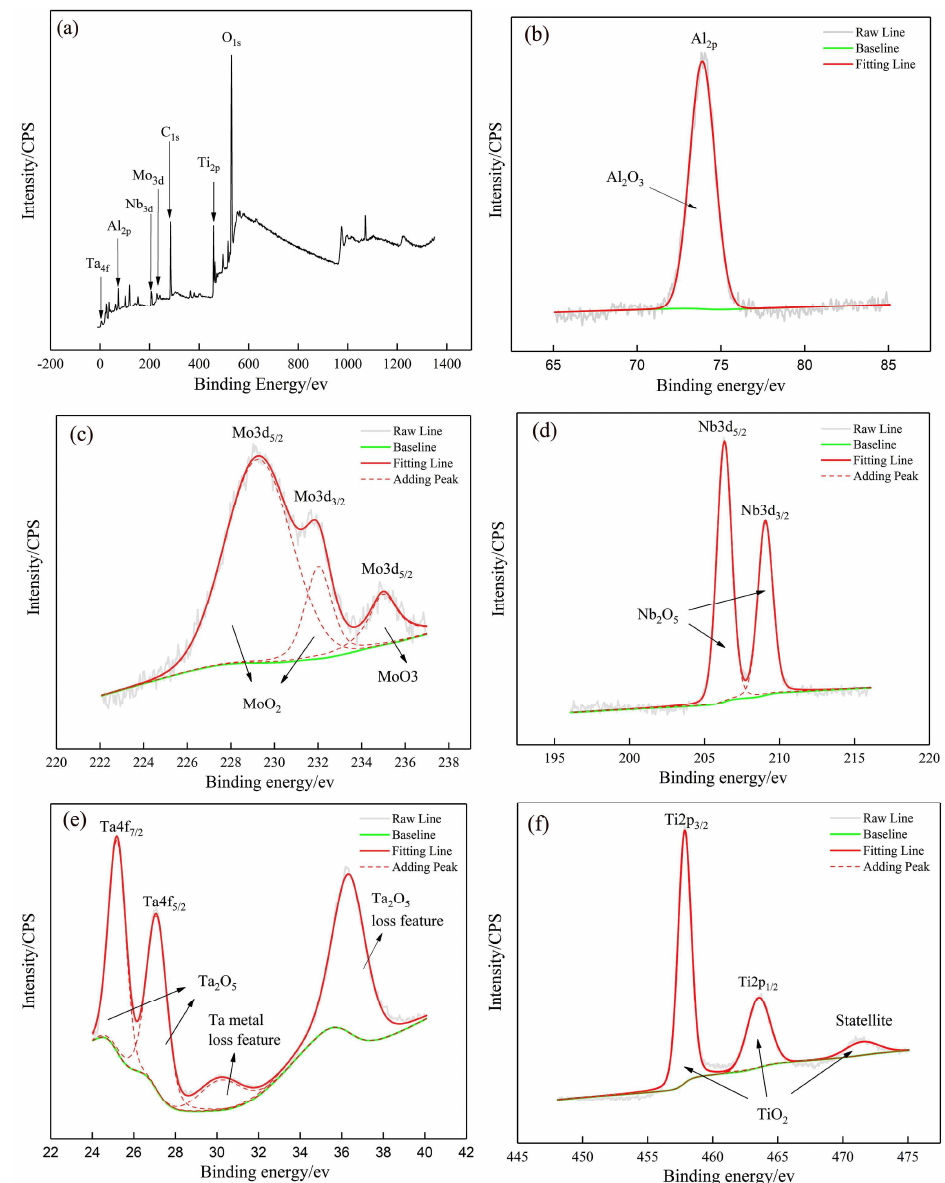
Figure 13. XPS spectra for the oxide film on the surface of the coating with x = 1.5 after exposed to 1000 °C in air for 120 h: ( a ) survey spectrum, ( b ) Al 2p spectrum, ( c ) Mo 3d spectrum, ( d ) Nd 3d spectrum, ( e ) Ta 4f spectrum and ( f ) Ti 2p spectrum.